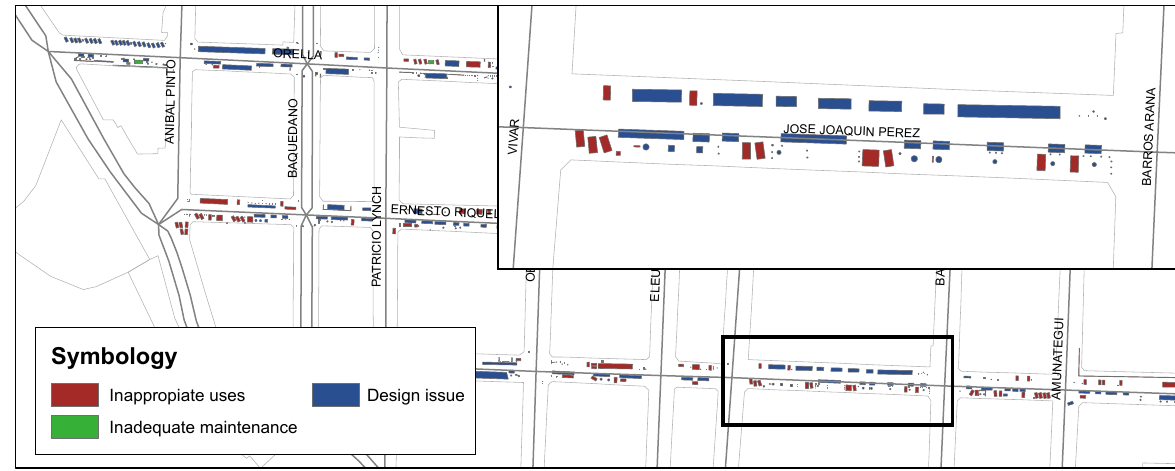
Figure 4. Mapping of identified micro-vulnerabilities, colored according to their taxonomy.